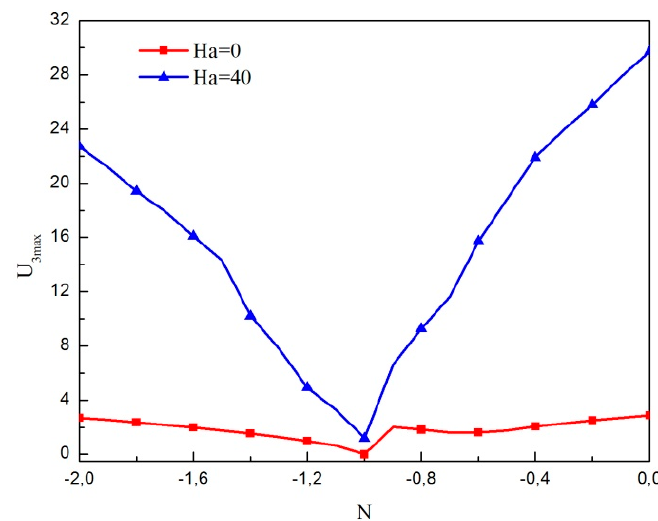
Figure 11. Variation of U 3max according to buoyancy ratio without (Ha = 0) and with magnetic field (Ha = 40) for Pr = 6.2, Le = 1, Ra = 10 5 and φ = 0.04.